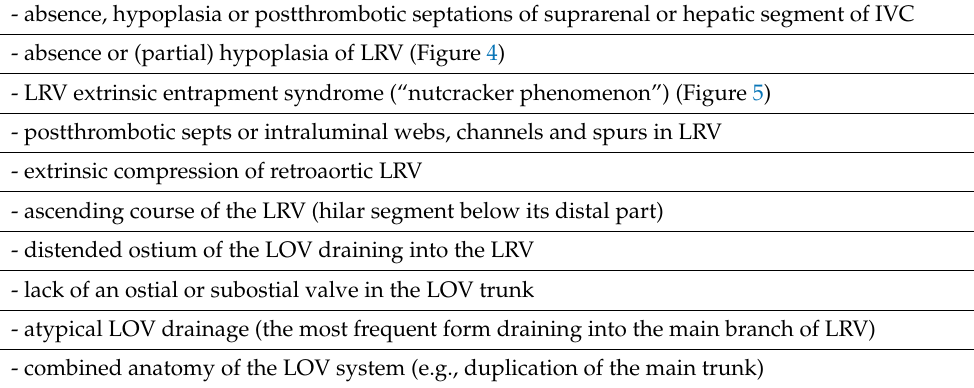
Table 2. The most important anatomical factors correlated to LOV